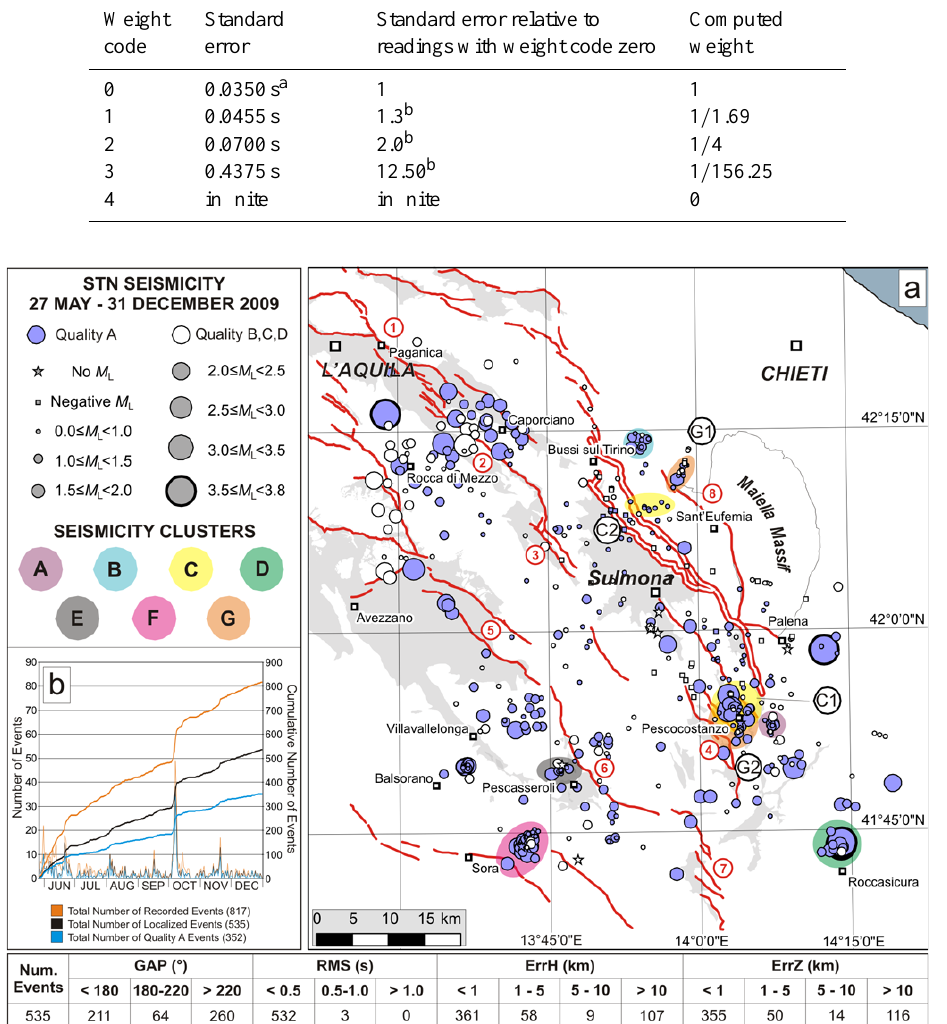
Fig. 9. Seismicity recorded by STN in the Sulmona area (Abruzzo region) from 27 May to 31 December 2009. (a) Epicentral distribution of the 535 events localized by using Hypoellipse (Lahr, 1980, 1984, 1999) and the best 1-D velocity model estimated for this area. Symbol colours refer to the quality of earthquake locations; symbol shape and dimension refer to their local magnitude. Coloured areas (A–G) point out the seismicity clusters corresponding to seismic swarms as described in the text. For location map of the represented area and legend, see Fig. 1. (b) Number and cumulative number of earthquakes versus time; location quality is given with respect to relocated events, described in Sect. 5. At the bottom is a summary of locations quality (GAP, RMS, horizontal error (ErrH) and vertical error